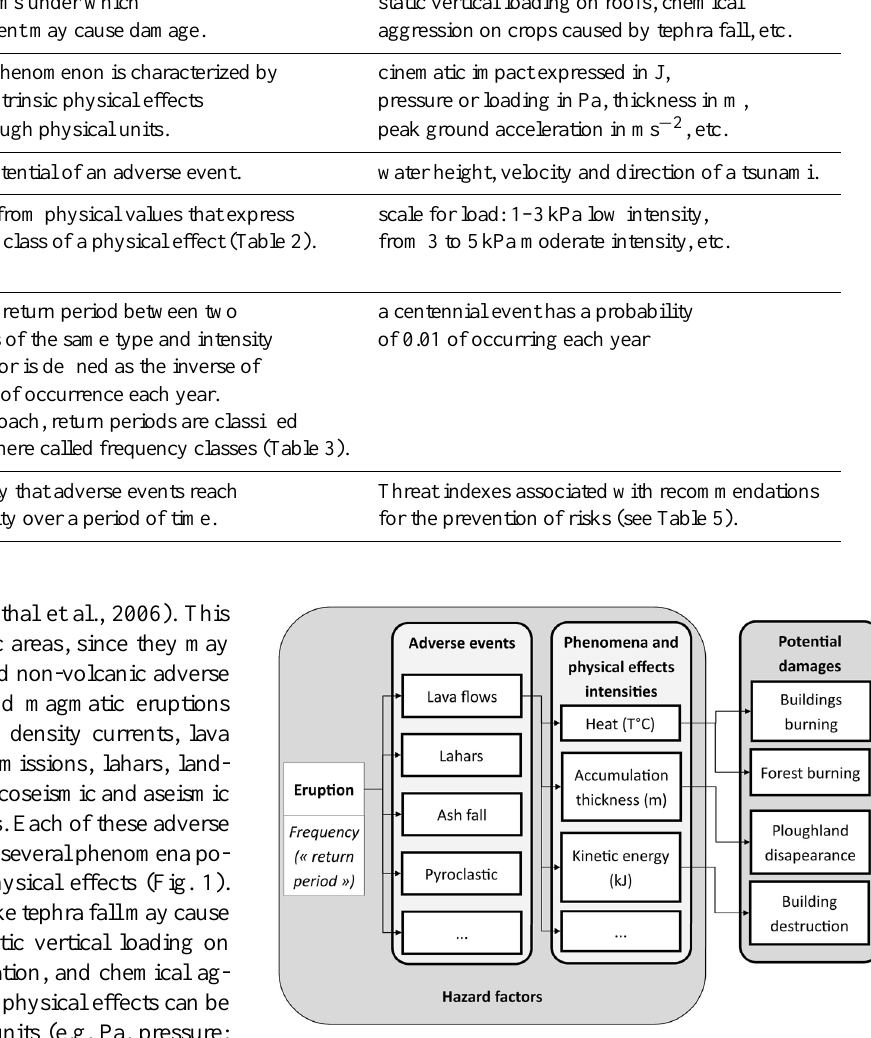
Fig. 1. Scheme showing an example of factors to take into account for hazard mapping according to the proposed